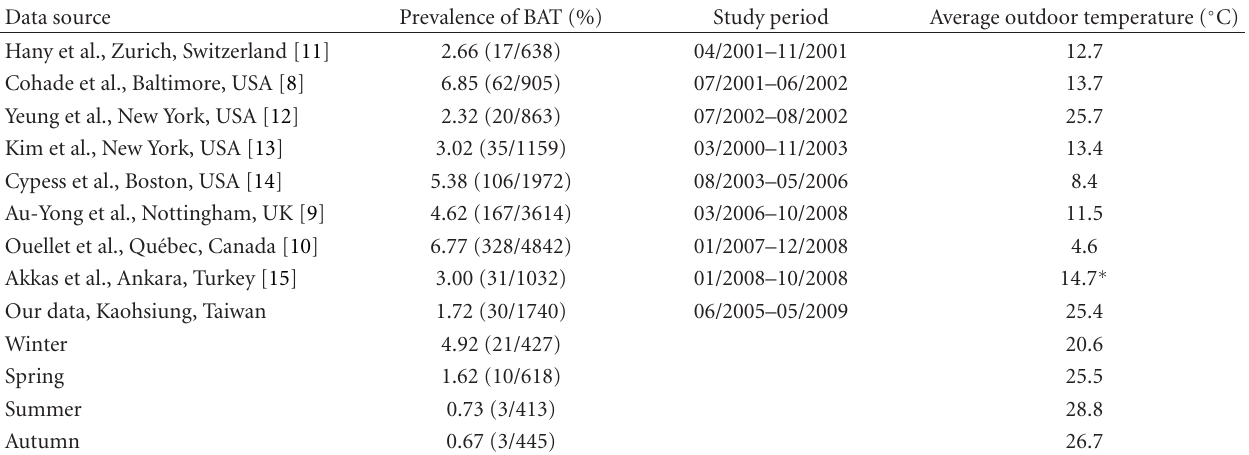
Table 1: Prevalence of activated BAT (detected by 18 F-FDG uptake) and average outdoor temperature during the study period. Data source